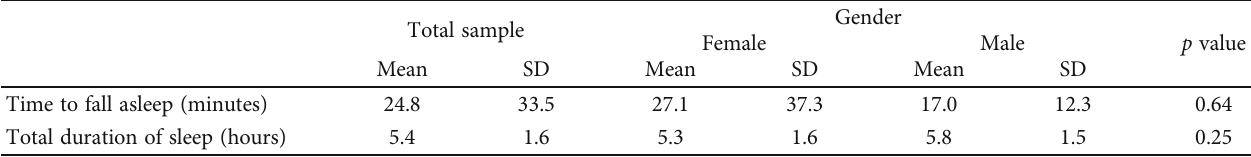
Table 3: Average time to fall asleep and total duration of sleep based on gender.